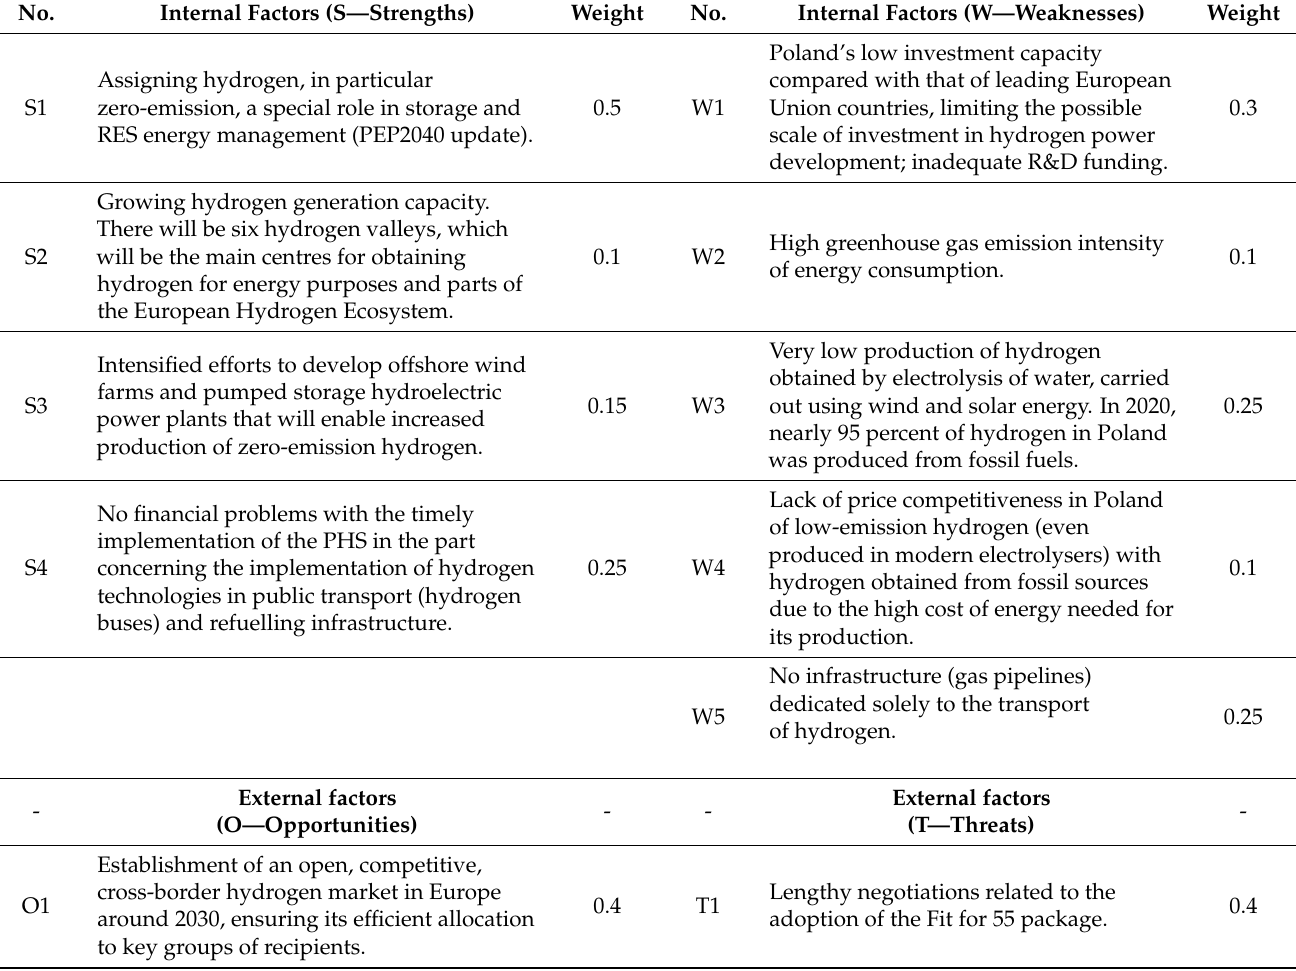
Table 2. The factors of the SWOT/TOWS analysis of the hydrogen economy in Poland and their